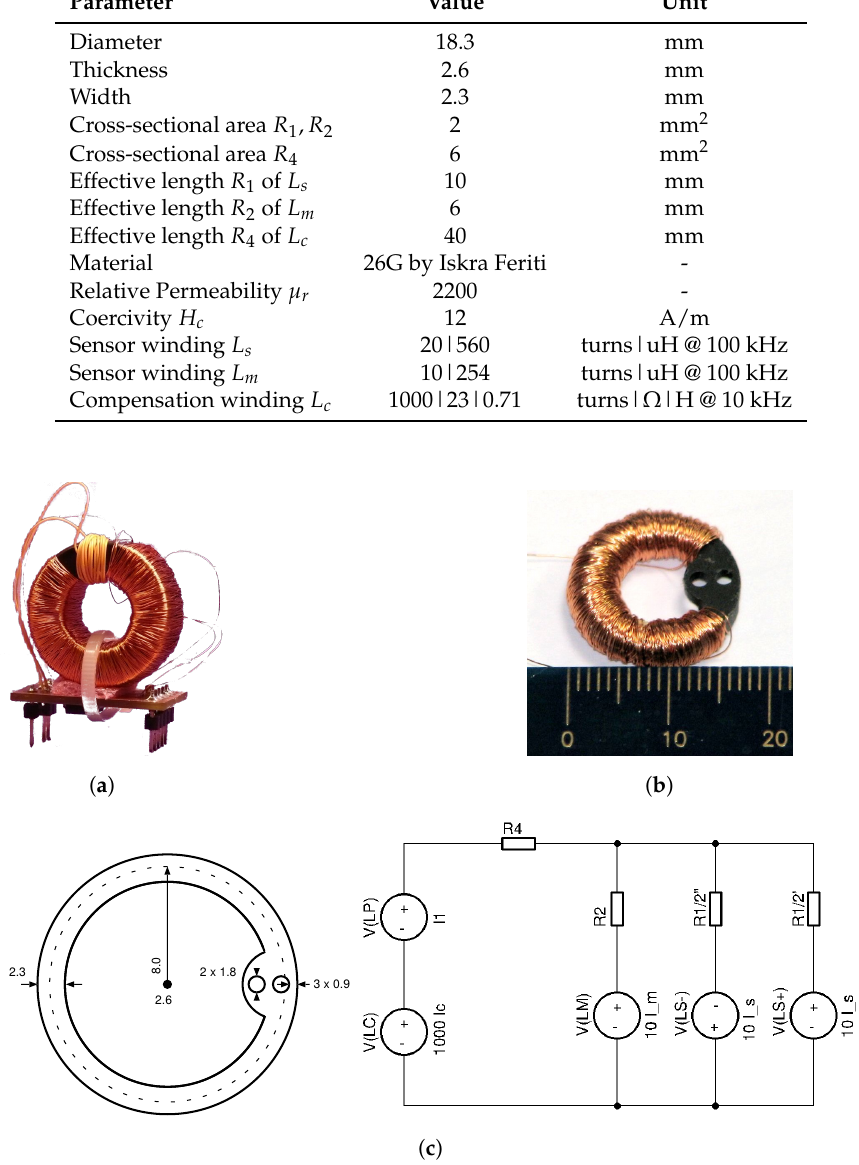
Figure 8. Soft ferrite core prototypes. ( a ) The first proof-of-concept ± 40 A DC-CT; ( b ) The first custom made toroid DC-CT core 40A9R; ( c ) Drawing in mm with simplified schematics of the core